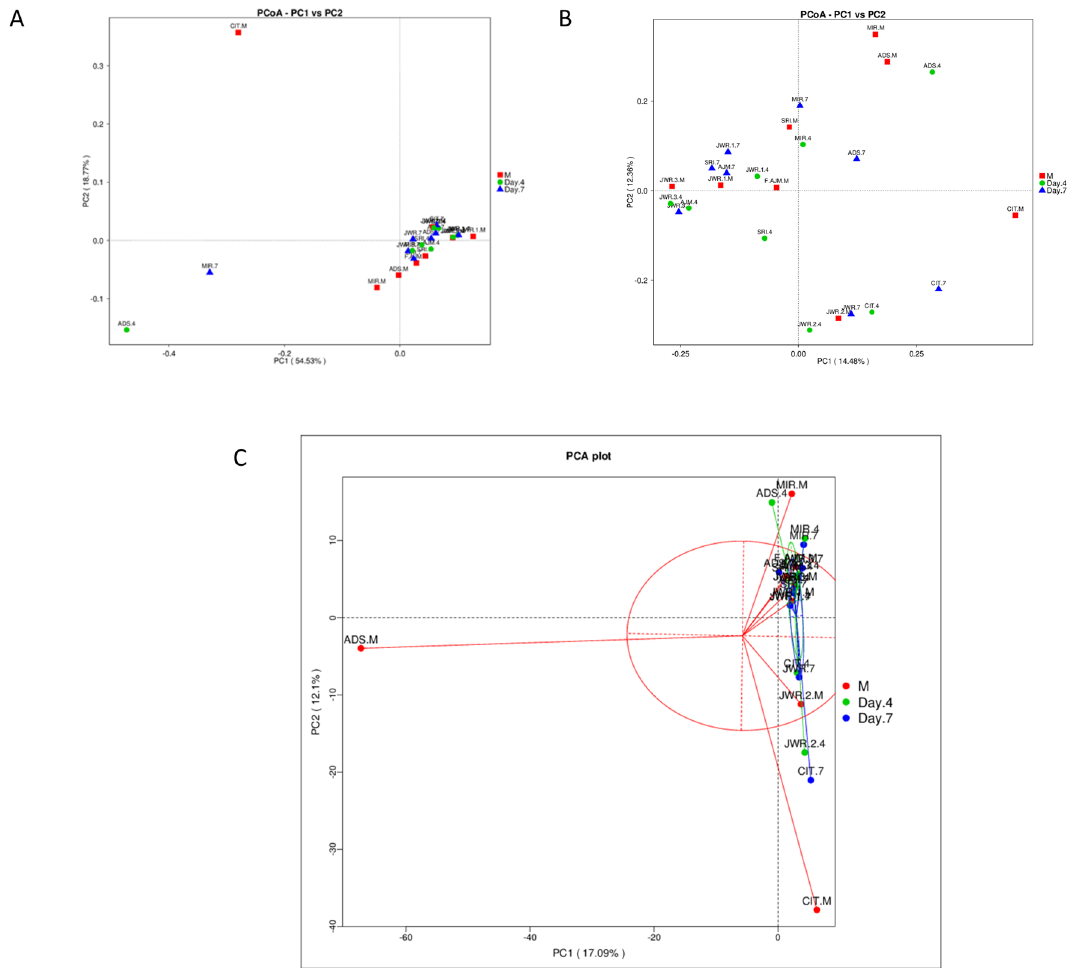
Figure 3. Beta diversity analysis results displayed by a PCoA plot based on ( A ) weighted UniFrac ( B ) unweighted UniFrac distances. ( C ) Shows a PCA plot. Generated by using R Software 24 .